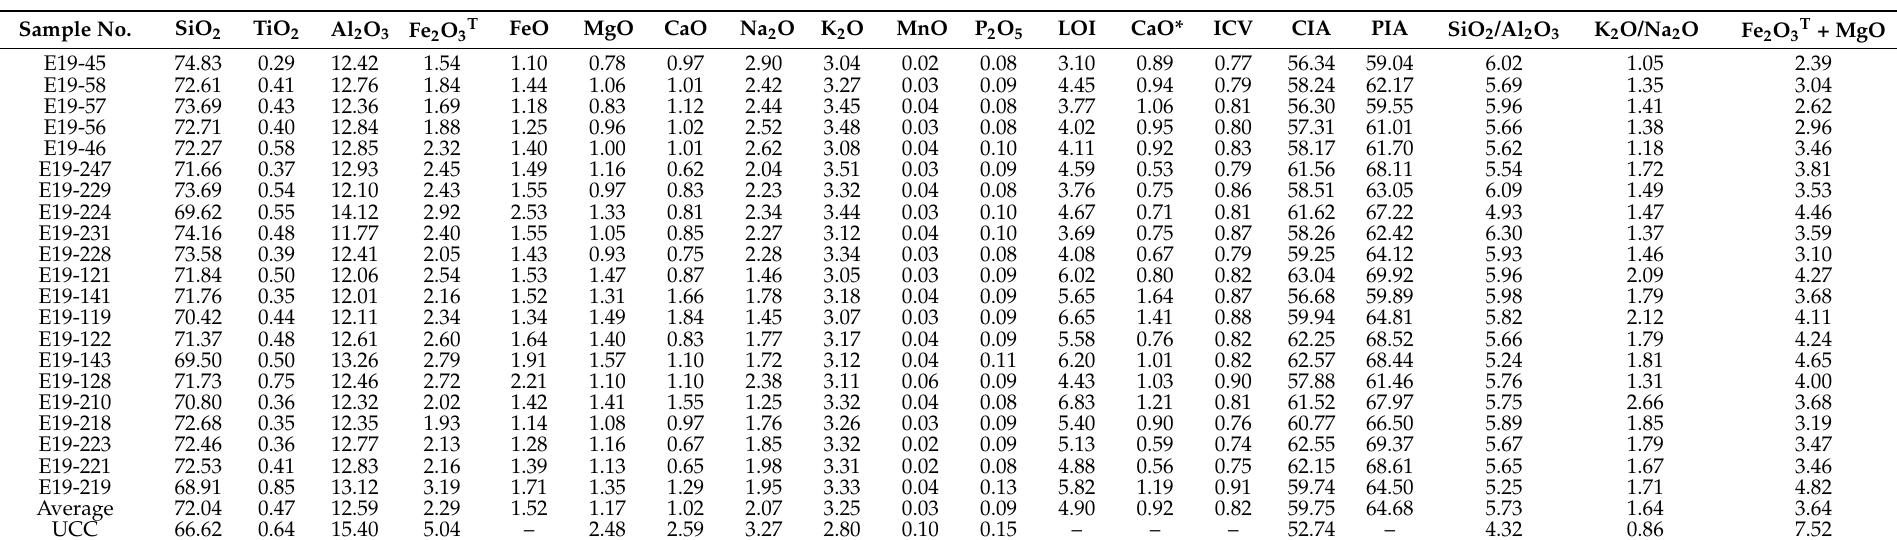
Table 1. Major oxide concentration in wt% of sandstones from the Zhiluo